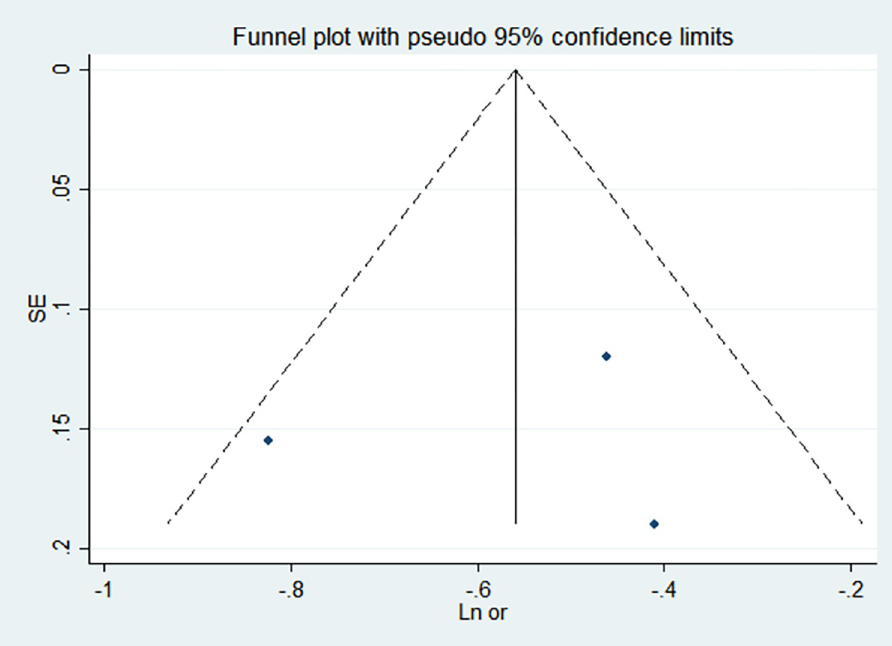
Fig 12. Funnel chart of gestational age.